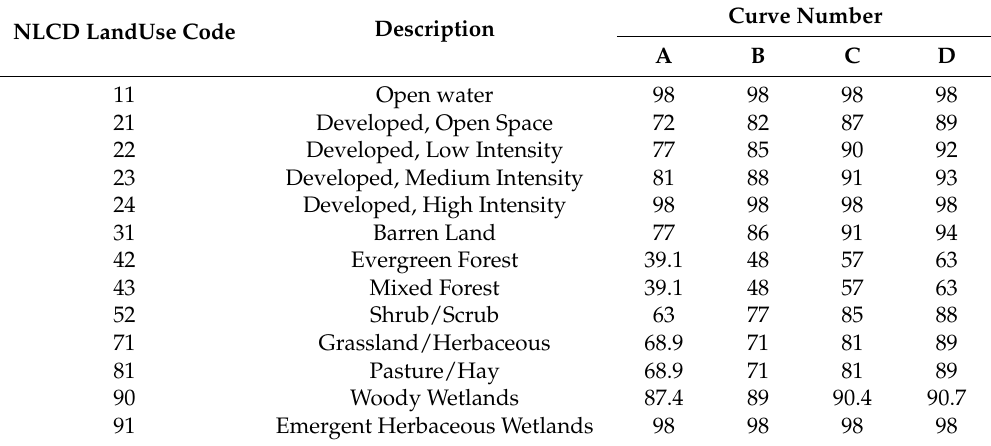
Figure 3. Spatial distribution of hydrologic soil group assignments ( a ), available soil moisture capacity ( b ), soil complex units ( c ), and depth to restrictive layer ( d ) for Catalina Island. Table 3. Curve Numbers for Hydrologic Soil